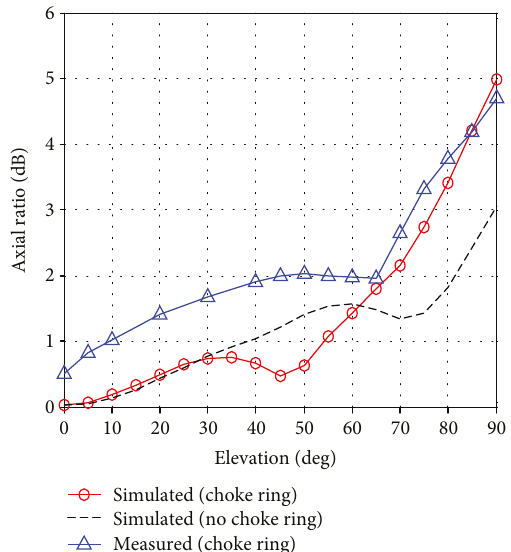
Figure 10: Comparison of simulated with/without choke ring and measured radome: maximum axial ratio versus the elevation angle at 2.5GHz.